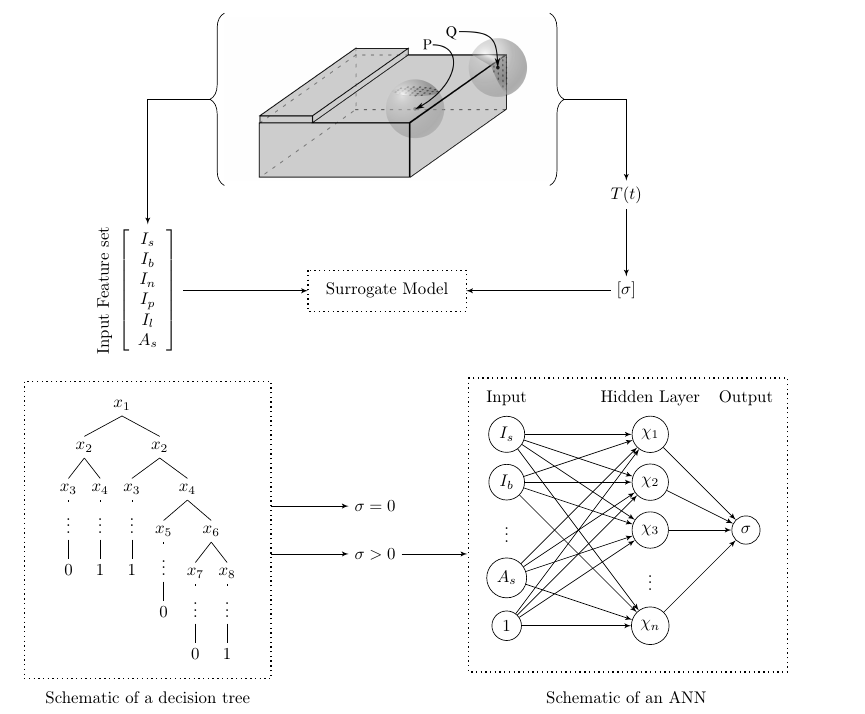
Figure 6: Structure of the surrogate model. The surrogate model consists of a decision tree followed by a single layer shallow artificial neural network. This is due to excessive cooling and non-optimal deposition pattern. For the selected geometries, the printing pattern plays a major role in the consolidation degree. Even though some sections of the parts achieve higher consolidation, it is still far from the ultimate strength (maximum 20% of the UTS is achieved). Such behavior is associated with the large size of the part. Nevertheless, the data exhibit a wide range of thermal behavior and constitutes a good testing set for the feature engineering analysis. The surrogate model was built to augment the speed of the numerical model while maintaining a certain level of accuracy. While the accuracy of the surrogate model is visualized qualitatively in Figure 7, a quantitative evaluation is presented in Table 3. We evaluate the capabilities of the surrogate model in terms of both speed and accuracy with respect to the numerical model for both testing and training geometries. The model was tested with the data from the digits three, five, seven, nine, and zero. Each row of the table